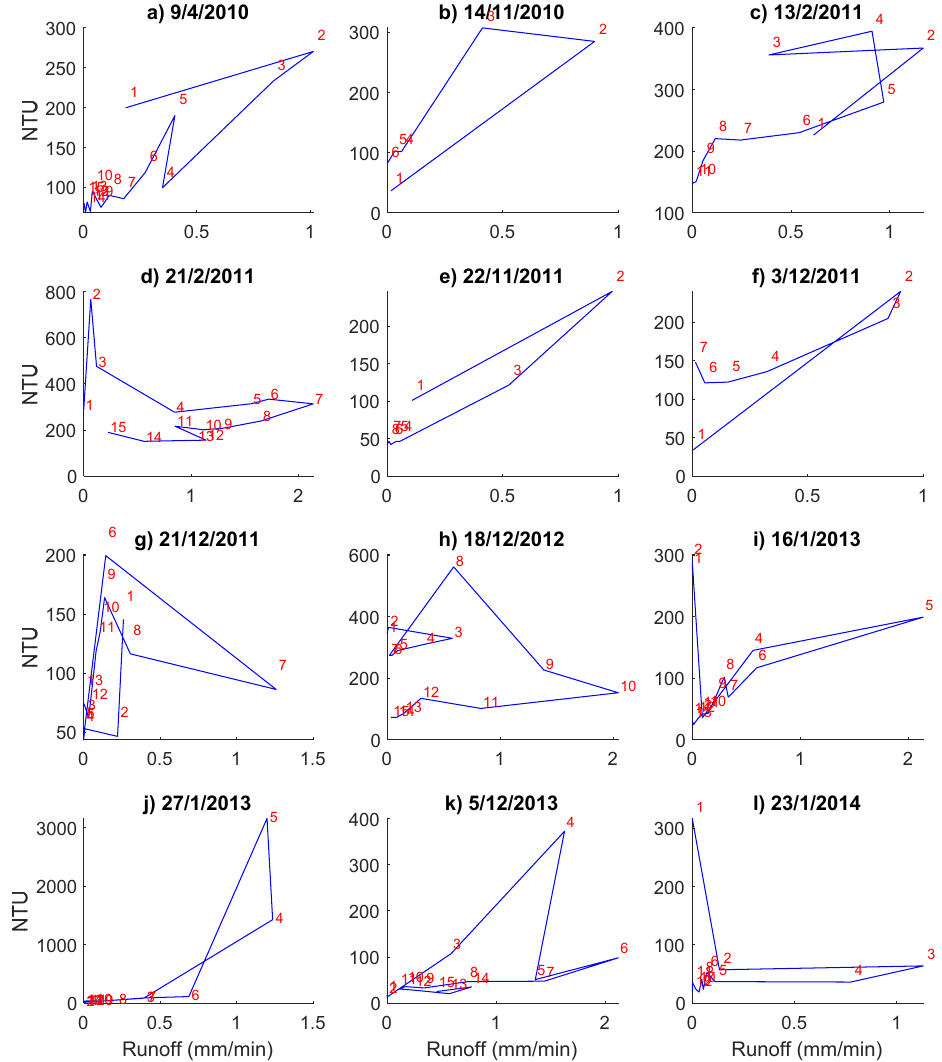
Figure A4. Runoff versus NTU hysteresis for 12 example events corresponding to Figure 8. The numbers in red show the time sequence of data points: ( a ) 9/04/2010, ( b ) 14/11/2010, ( c ) 13/2/2011, ( d ) 21/2/2011, ( e ) 22/11/2011, ( f ) 3/12/2011, ( g ) 21/12/2011, ( h ) 18/12/2012, ( i ) 16/1/2013, ( j ) 27/1/2012, ( k ) 5/12/2013 and ( l ) 23/1/2014.